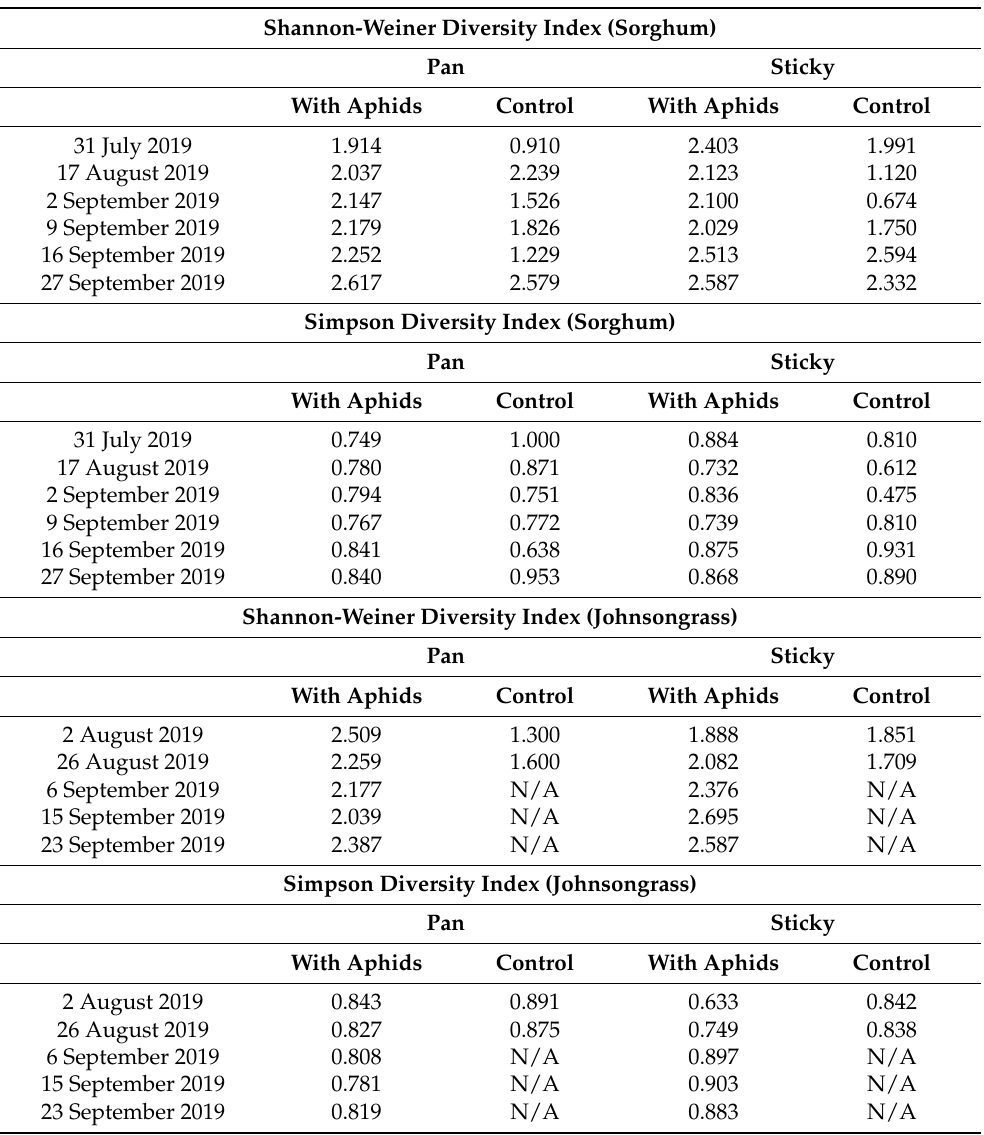
Table 5. Diversity indices of Hymenoptera collected using pan or sticky traps from sorghum and Johnsongrass infested with sorghum aphid or uninfested